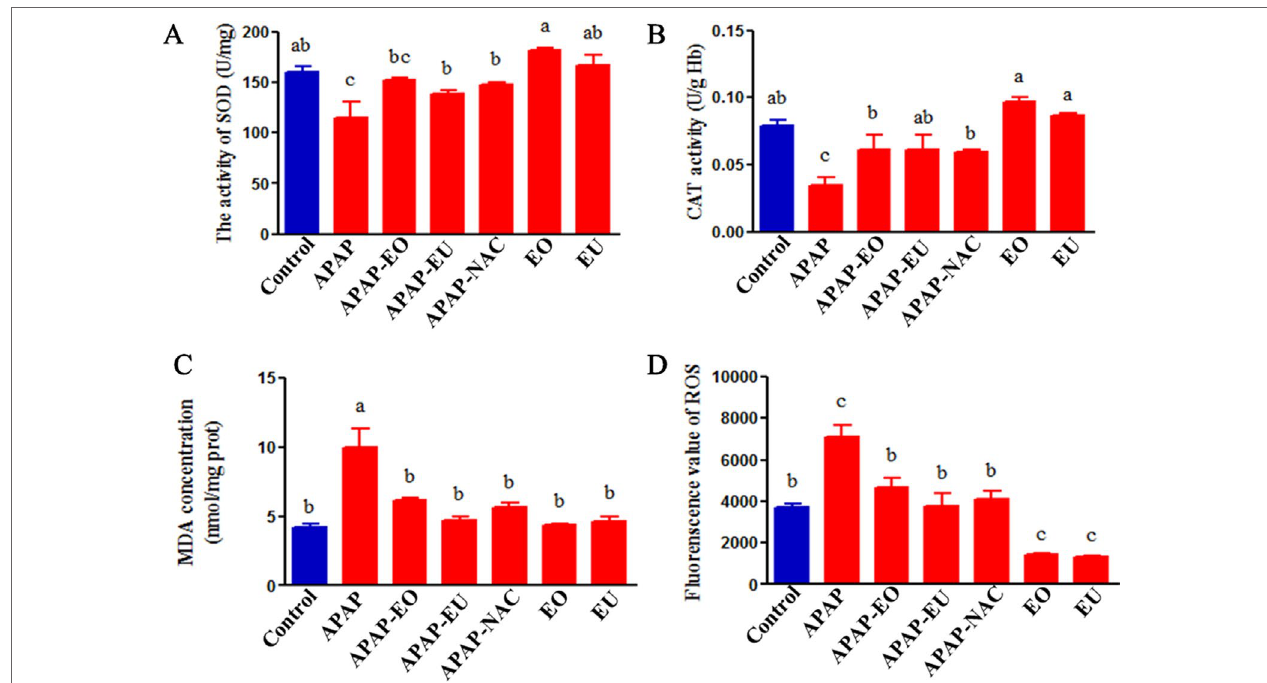
FIGURE 4 | Effects of essential oil and eucalyptol on the APAP-induced oxidative stress parameters. a, b, c different letters indicate statistically different groups ( p < 0.05).